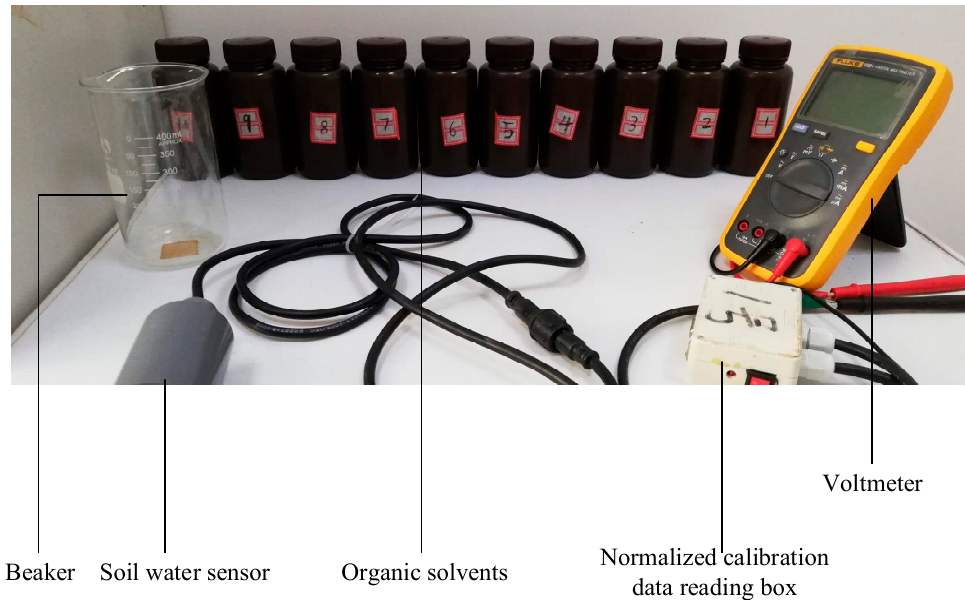
Figure 5. Photograph of normalized calibration.